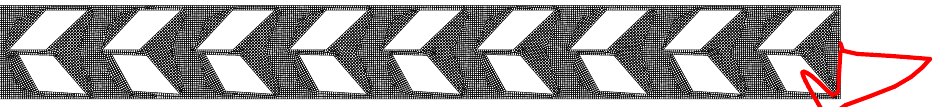
Figure 8. Result from the three-element optimisation design expanded to the full nine-unit actuator. FE mesh is shown in black with the tip displacements traced in red.